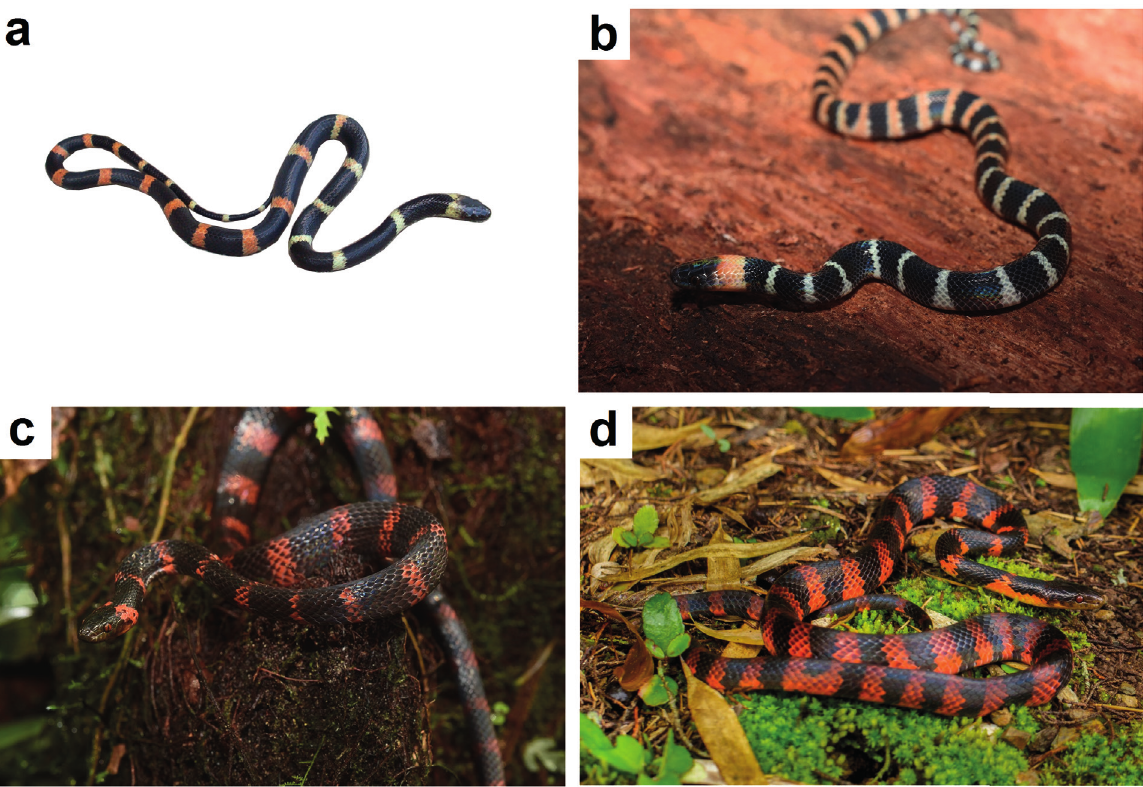
Figure 7. Comparison of Oxyrhopus cf. erdisii and Oxyrhopus emberti . a: Juvenile specimen of O. emberti (MNKR 4369) from Departamento Santa Cruz, Bolivia; b: Unvouchered juvenile O . cf. erdisii from La Paz, Bolivia (note its narrower black bands); c: Unvouchered adult O . cf. erdisii from La Paz, Bolivia; d: Adult female O . cf. erdisii from La Paz, Bolivia (MNKR, voucher unavailable). Photo credits: Mauricio Pacheco